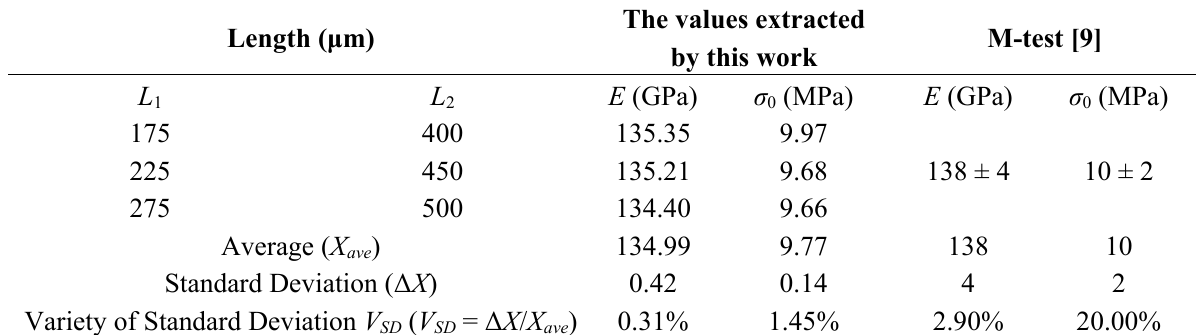
Table 3. Extracted Young’s modulus and mean stress of the mono-crystalline silicon in (100) crystalline plane and the comparison with Osterberg’s work [9].